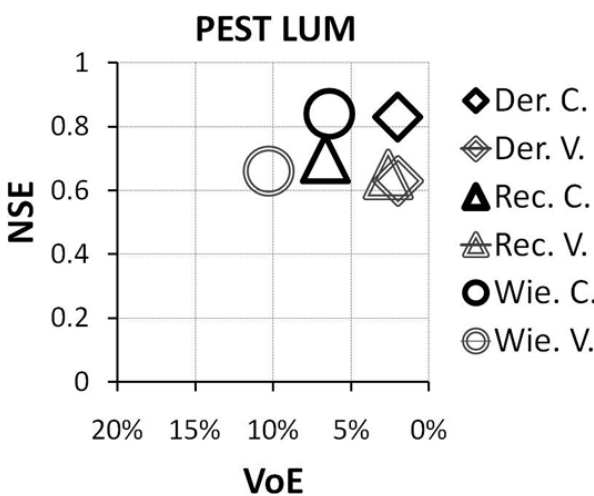
Fig. 5. Model performance for the Lumped calibration strategy in combination with the PEST optimisation algorithm. The ideal point with an NSE = 1 and a VoE = 0 is shown in the top right corner. (Der. = Derneburg; Rec. =Reckershausen; Wie.= Wieckenberg;